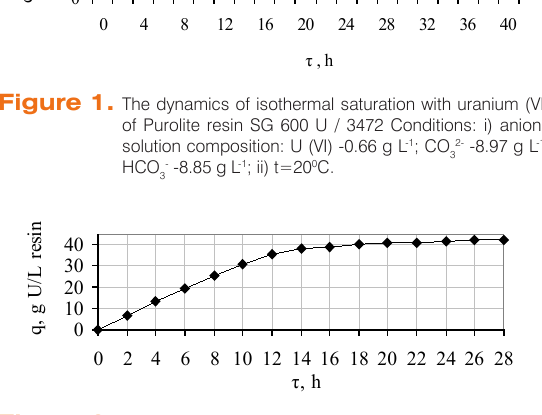
Figure 2. The dynamics of sothermal saturation with uranium (VI) of Purolite resin SG 600 U / 3472. i) anions solution composition: U (VI)-0.66 g L -1 , CO 32- -8.97 g L -1 , HCO 3- -8.85 g L -1 , SO 42- -10 g L -1 ; ii) t=20 0 C.